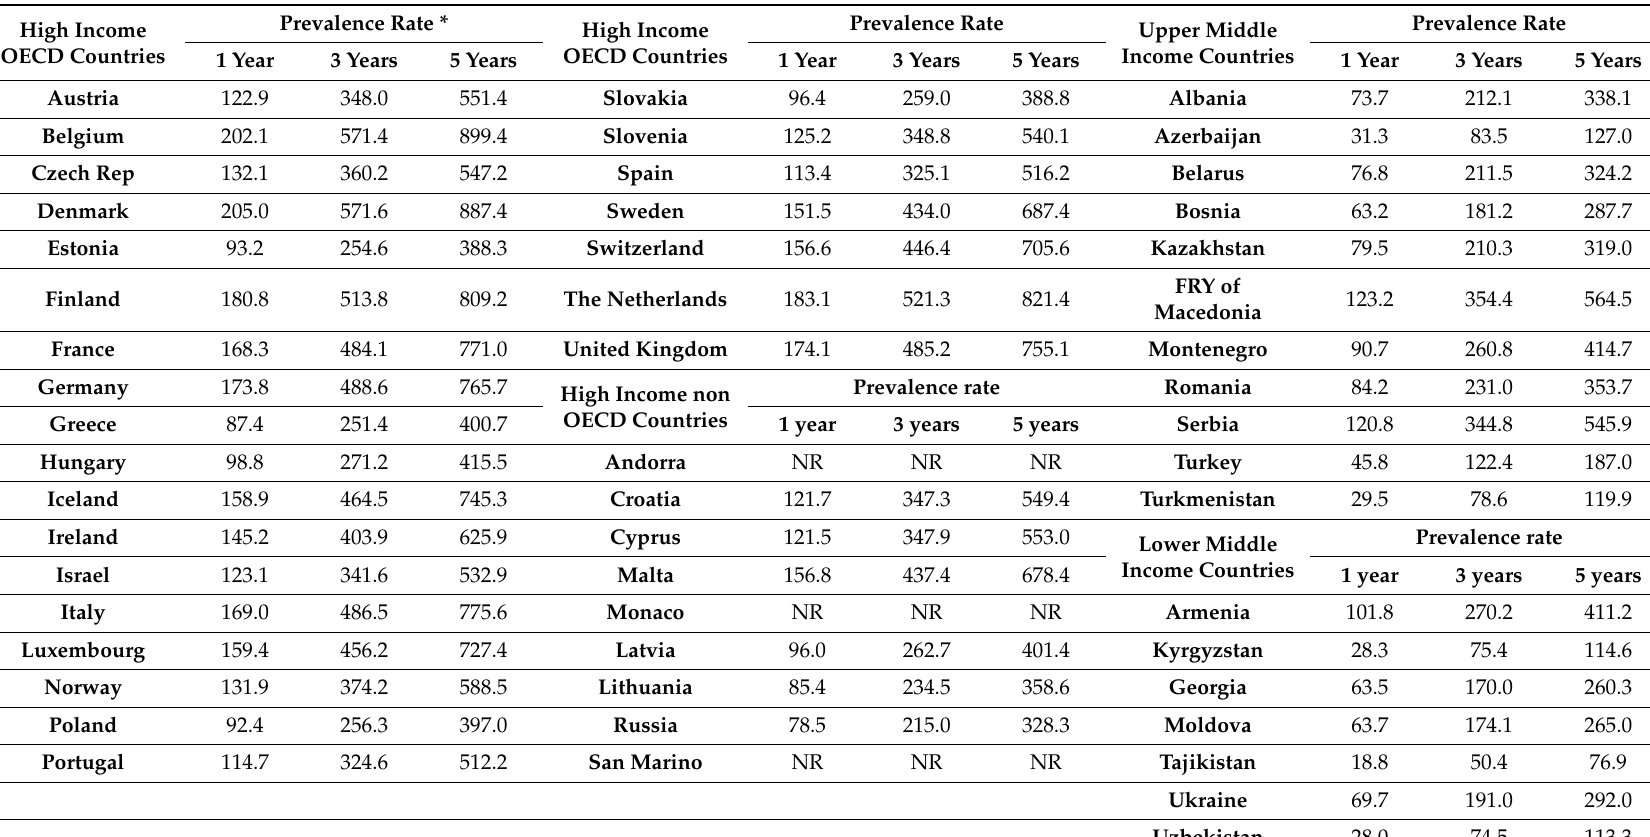
Table 1. Breast Cancer prevalence for each country of WHO European Region by gross income levels according to World